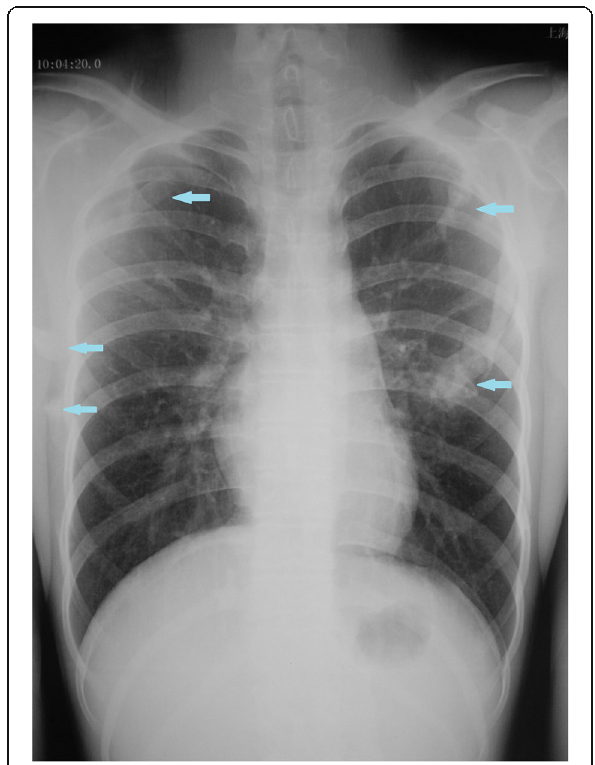
Fig. 1 Chest radiograph showing widespread heterotopic ossification along the chest wall surrounding the scapulae (arrows)